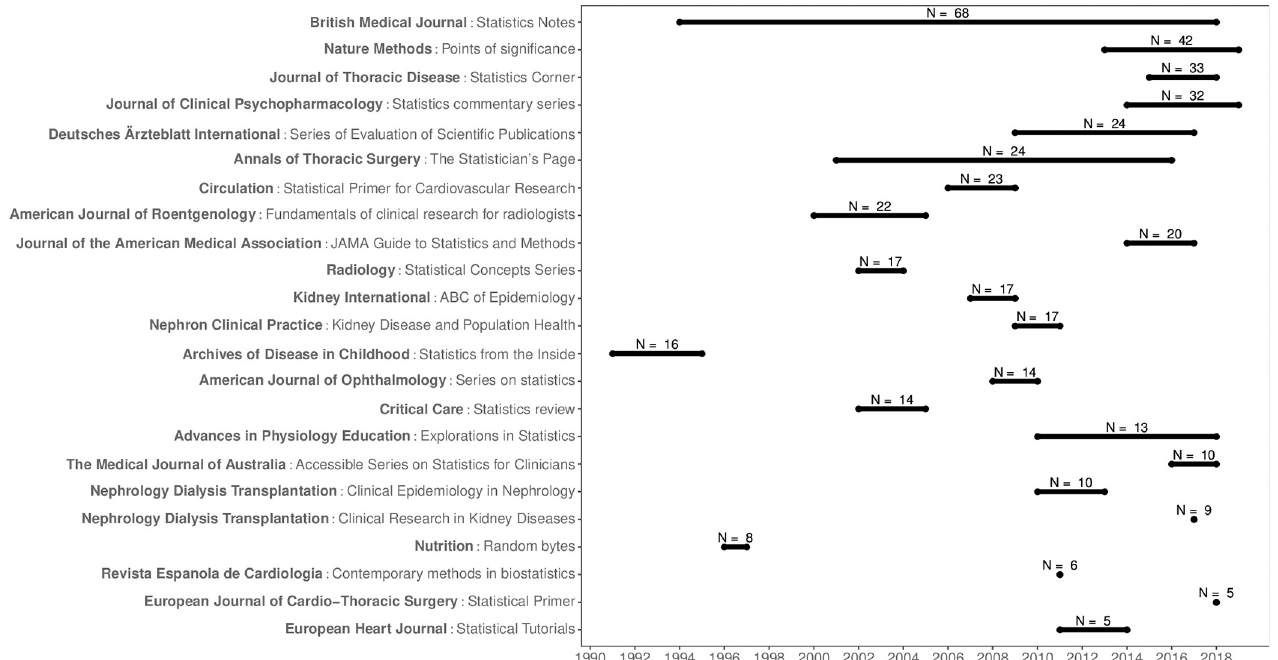
Fig 2. Publication years and number of articles in statistical series from highest to